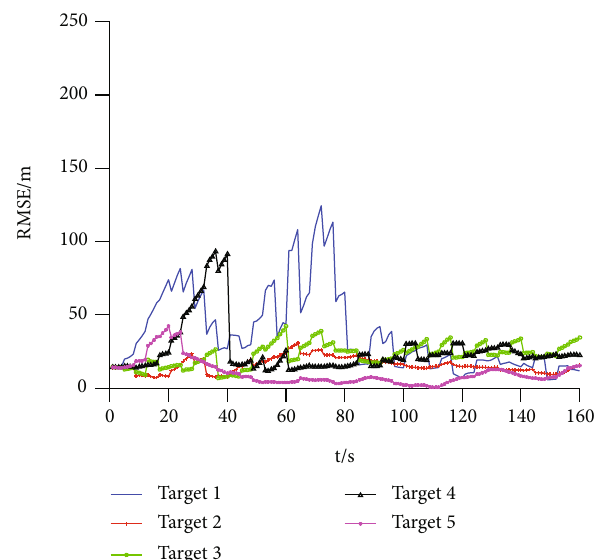
Figure 6: The position RMSE versus time scans of fi ve targets.